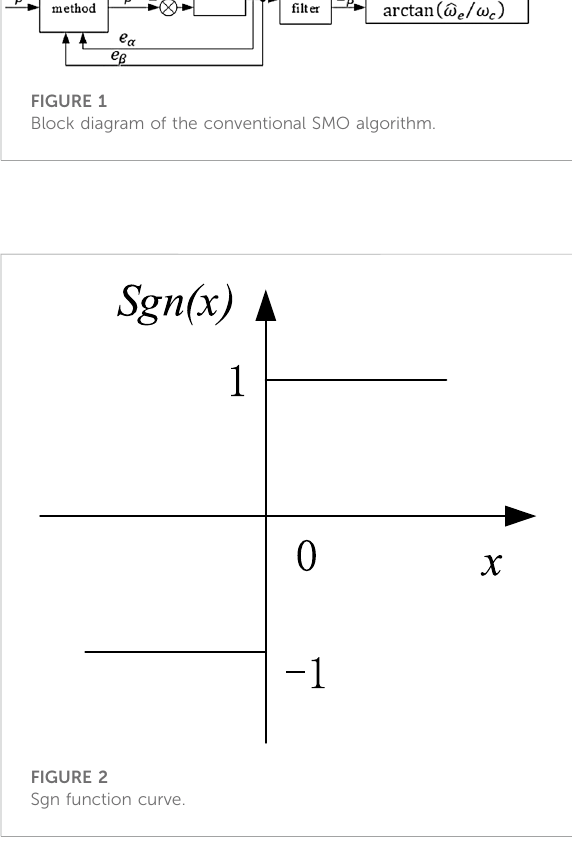
FIGURE 2 Sgn function curve.